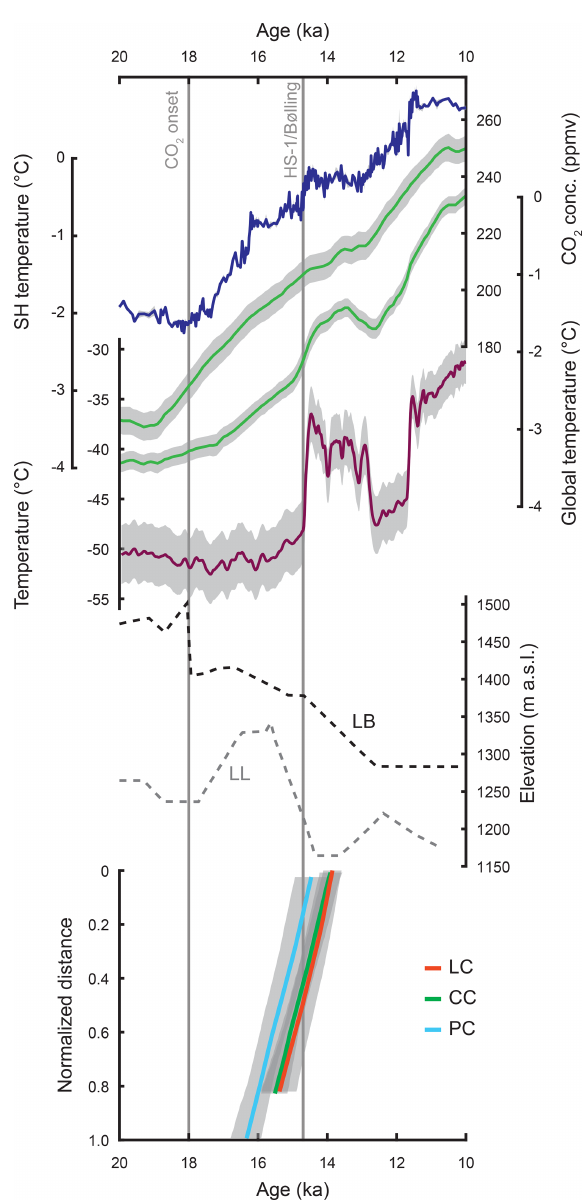
Figure 5. Deglaciation of the Sawatch Range compared to other cli- mate proxies. From top to bottom: atmospheric CO 2 concentrations (Bereiter et al., 2015); global and Southern Hemisphere tempera- ture stacks (Shakun et al., 2012); synthesized Greenland tempera- ture from ice cores (Buizert et al., 2014); lake level reconstructions of Lake Bonneville (LB; black dashed line) and Lake Lahontan (LL; gray dashed line) from Reheis et al. (2014); normalized BACON plots from Lake Creek (LC; orange), Clear Creek (CC; green), and Pine Creek valleys (PC; blue). Vertical lines correspond to the onset of CO 2 rise beginning ∼ 18ka and the Heinrich Stadial 1–Bølling transition at